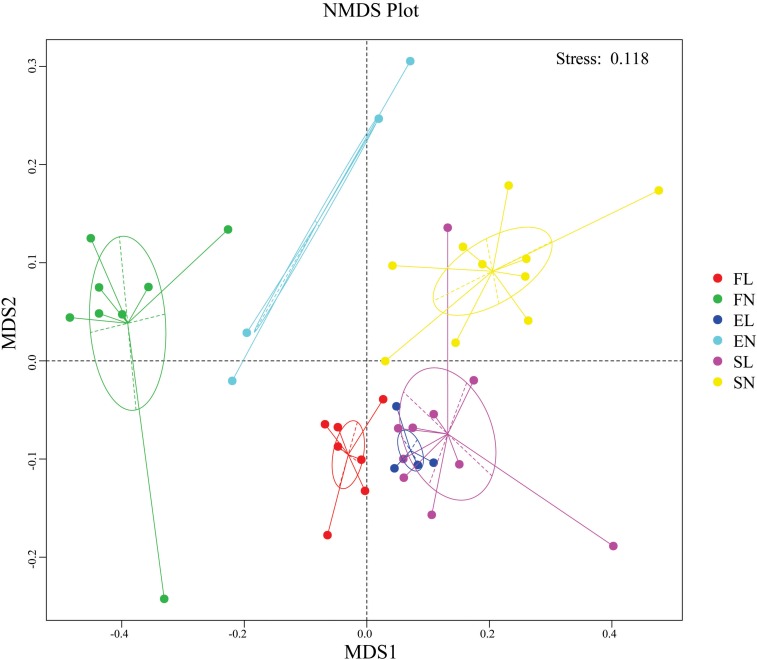
NMDS analysis were used to show the distribution of sample. NonMetric MultiDimensional Scaling, FL, black locust in forest habitat; FN, native plants in forest habitat; EL, black locust in forest-steppe habitat; EN, native plants in forest-steppe habitat; SL, black locust in steppe habitat; SN, native plants in steppe habitat.